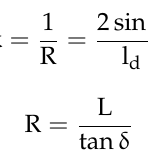
Algorithm 2 Main steps of path tracking